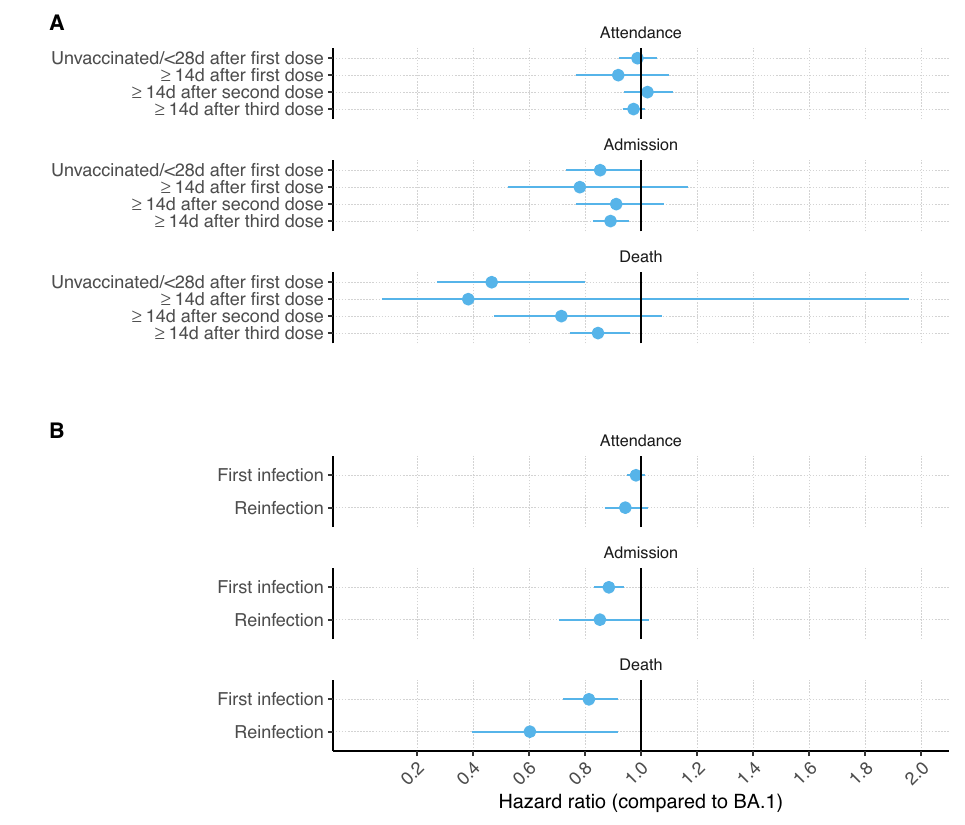
Fig.3|Relativeriskofhospitalattendance,admissionordeath,byvaccination status and reinfection status. Risk of hospitalisation and mortality by vaccina- tion status and reinfection status, for COVID-19 cases with Omicron lineage BA.2 compared to BA.1 in England, 01 December 2021 – 2025 March 2022. The central measuresareadjustedhazardratiosandtheerrorbarsarethecorresponding95% con fi dence intervals (CI) from Cox regression models with an interaction term between variant (BA.2 vs BA.1), and vaccination ( A total n =1,243,212; unvacci- nated or ≤ 28 days after vaccination=247,748; ≥ 28 days after fi rst dose=64,694; ≥ 14 days after second dose=294,071; ≥ 14 days after third dose=537,822) or reinfection ( B total n =1,243,212; reinfection=125,239; fi rst infection=1,117,973) status. Themodels were strati fi ed forexact specimen date, area of residence,